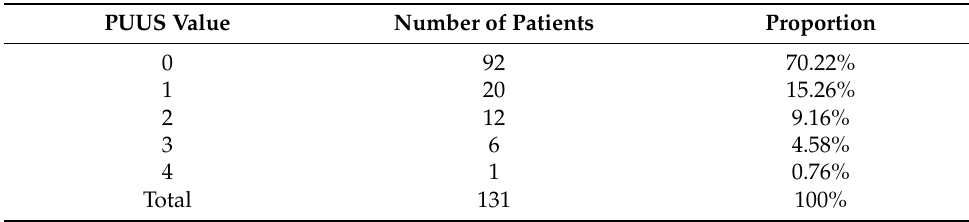
Table 1. Distribution of patients regarding the PUUS value.